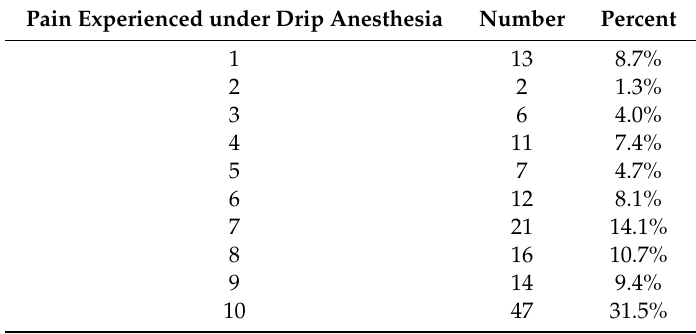
Table 5. Intensity of pain experienced by patients under drip anesthesia.